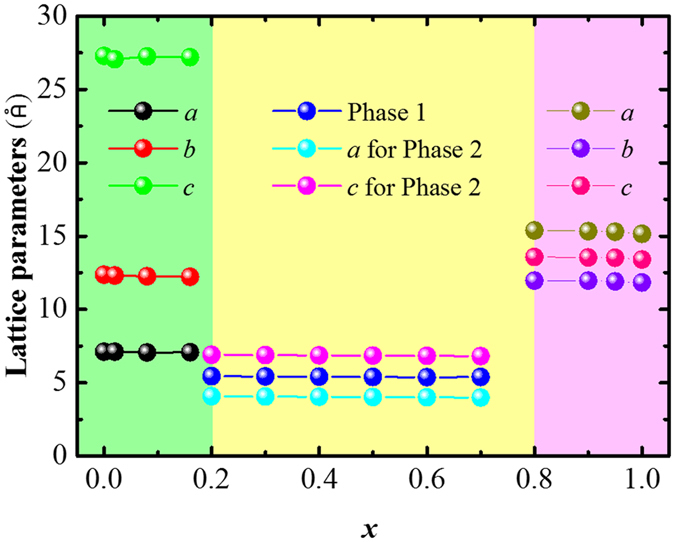
Phase diagram of sulphur doping level dependence of the crystal structures at room temperature.(I: monoclinic structured Cu2Se phase; II: Composites of cubic structured Cu1.8Se (Phase 1) and hexagonal structured Cu2.001S (Phase 2); III: orthorhombic structured Cu2S phase).